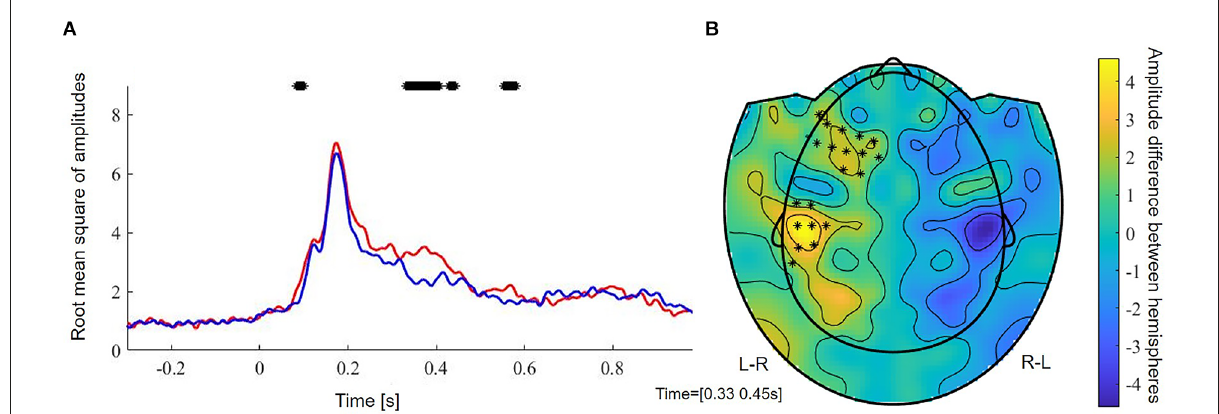
FIGURE3 (A) Root mean square of amplitudes across subjects of left (red) and right (blue) sensors. Stars reflect significant time samples. (B) Raw effect and results of cluster-based permutation test between 350 and 450 ms. Stars reflect significant sensors. L-R, activation in left minus activation in right sensors; R-L, activation in right minus activation in left sensors.